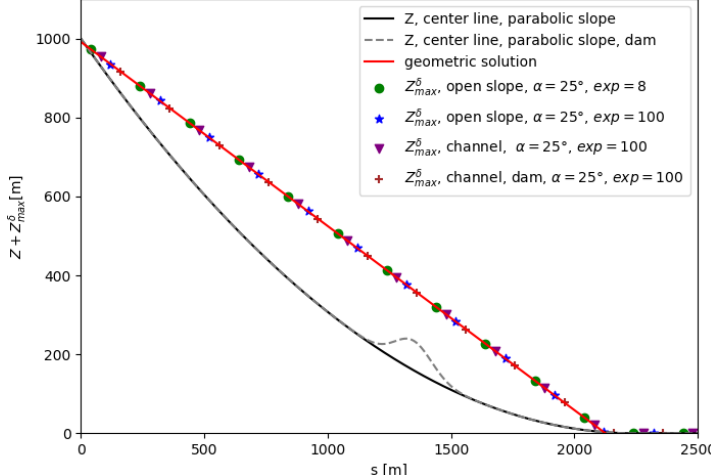
Figure 6. Geometric solution for the stopping criteria (red line) represented by the α line from starting to the runout points with Z δ max values for the centerlines of scenarios presented in Sect. 3.1–3.2 (black line) and 3.3 (black dashed